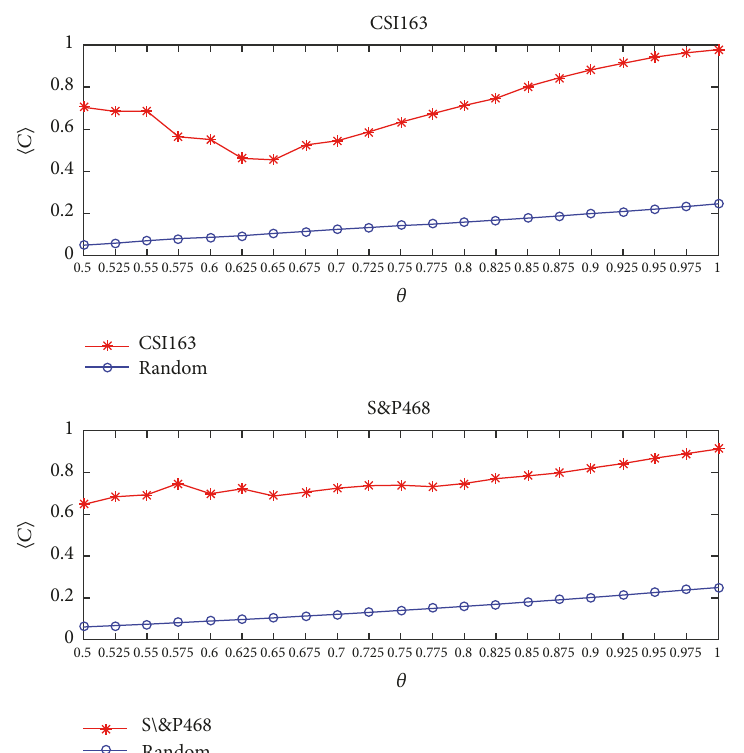
Figure 4: Average clustering coefficient ⟨𝐶⟩ of CSI163 and S&P468 for different thresholds 𝜃 . It shows that ⟨𝐶⟩ gets larger with 𝜃 . To compare with random networks, we plot the corresponding average clustering coefficients under the same interval of 𝜃 . As is shown, for both CSI163 and S&P468 networks, ⟨𝐶⟩ values are significantly larger than the random networks of the same size. This indicates the stock markets are far from random and the stocks are comparatively